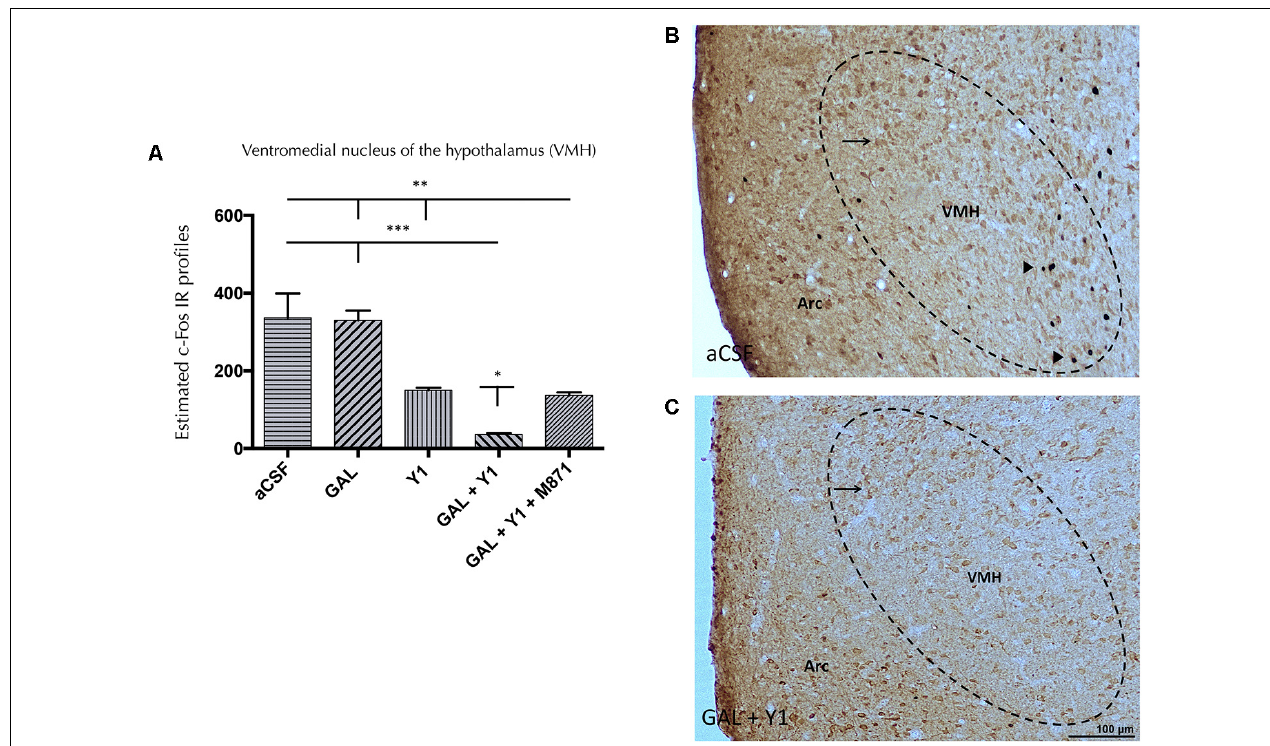
FIGURE 5 | c-Fos expression in ventromedial hypothalamic (VMH) nucleus after the intracerebroventricular (icv) administration of Galanin (GAL) and NPYY1R agonist, either alone or in combination together with the GAL 2 receptor (GALR2) antagonist M871. Quantification of total c-Fos IR nuclei in VMH (A) . Data, expressed as mean ± SEM showed the differences between groups after icv injection of aCSF, GAL, [Leu 31 -Pro 34 ]NPY, or the coadministration of both peptides and M871. N = 4 in each group. (A) GAL and the NPYY1 agonist coinjection decreased the c-Fos expression in the VMH compared with the effects of both peptides alone and the aCSF group. Furthermore, this effect was blocked by GALR2 antagonist M871. ∗ P < 0.05; ∗∗ P < 0.01; ∗∗∗ P < 0.001 according to one-way ANOVA followed by Newman–Keuls Multiple Comparison Test. Inter-group comparisons are indicated by the lines above bars. N = 4 in each group. Sections were double immunostained with Calbindin. GAL and NPYY1R agonist coinjection (C) decreased the c-Fos expression in non-calbindinergic neurons in the VMH compared with the control group (B) . Black arrowheads indicate neurons that are c-Fos+/Calbindin-; black arrows indicate neurons that are c-Fos-/Calbindin+. Dashed ovals represent measuring fields in VMH near the arcuate (Arc) hypothalamic nucleus (Bregma: –2.56 mm). Abbreviations: aCSF, cerebrospinal fluid; GAL, Galanin 3 nmol; Y1, NPY Y1 receptor agonist [Leu 31 -Pro 34 ]NPY 2,5 nmol; GAL + Y1, Coadministration of GAL and [Leu 31 -Pro 34 ]NPY; GAL+Y1+M871, Coadministration of GAL, [Leu 31 -Pro 34 ]NPY and GALR2 antagonist M871 3